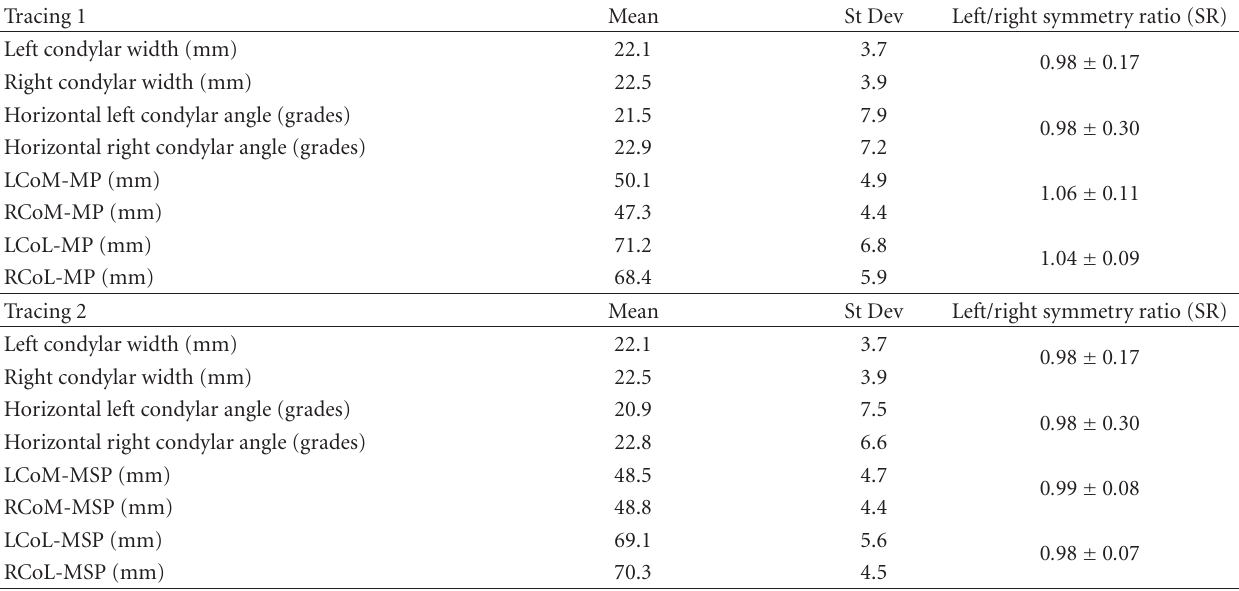
Table 1: Symmetry ratio of the variables analyzed.